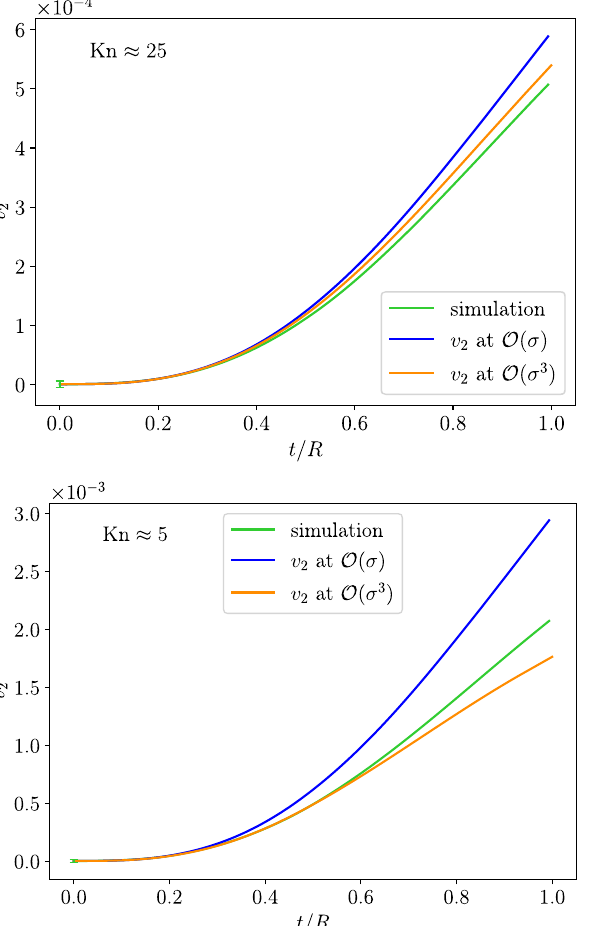
Fig. 6 Triangular flow v 3 as a function of t / R for Kn ≈ 25 (top) and Kn ≈ 5 (bottom). Results from the 2 → 0 collision kernel are shown in green and the analytical results are shown to O (σ 2 )